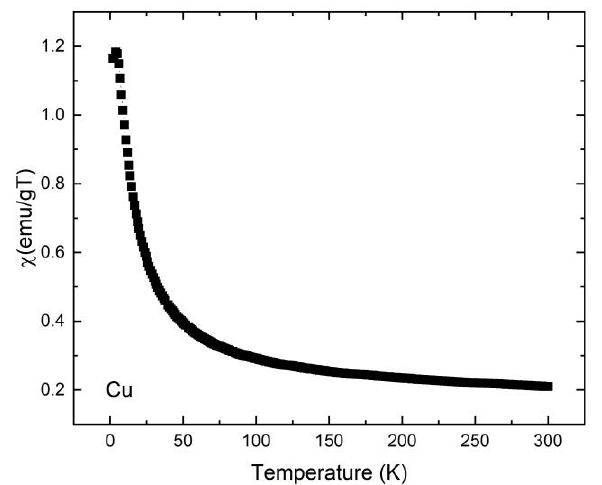
Figure 10. Magnetic susceptibility χ of Cu(L)Cl 2 as the function of temperature measured at 0.6 T. Cd(L)Cl 2 and Zn(L)Cl 2 samples presented featureless, nearly temperature-independent curves.